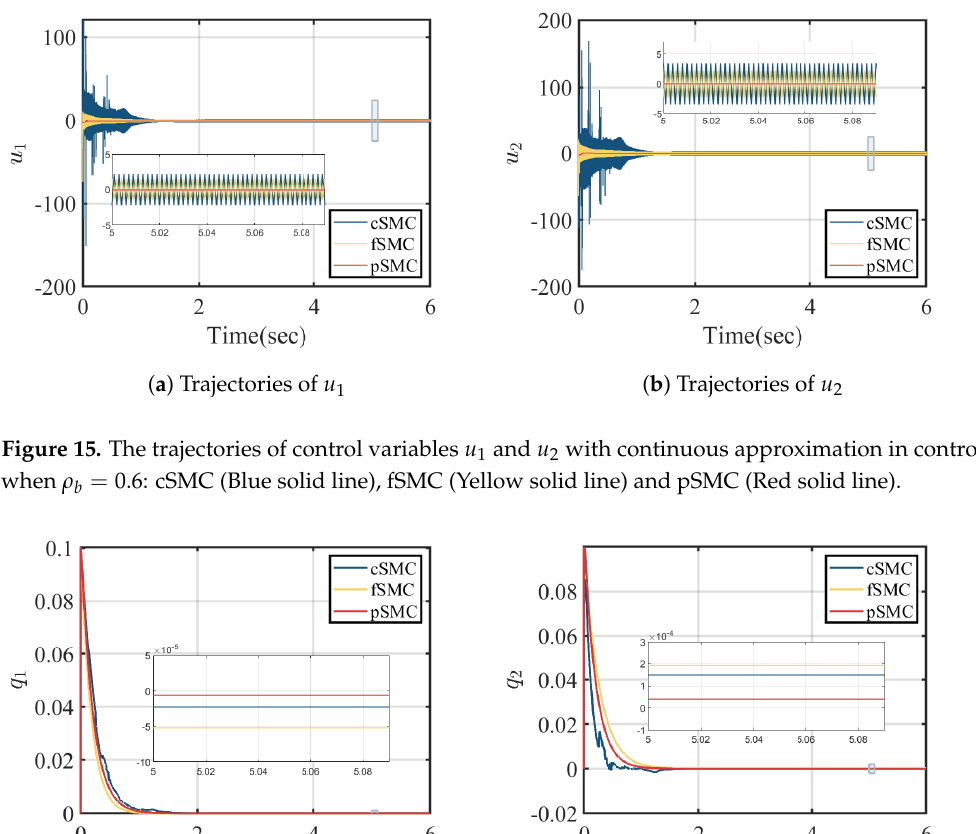
Figure 14. Thetrajectories of state variables q 1 and q 2 with continuous approximation in control when ρ b = 0.6: cSMC (Blue solid line), fSMC (Yellow solid line) and pSMC (Red solid line).